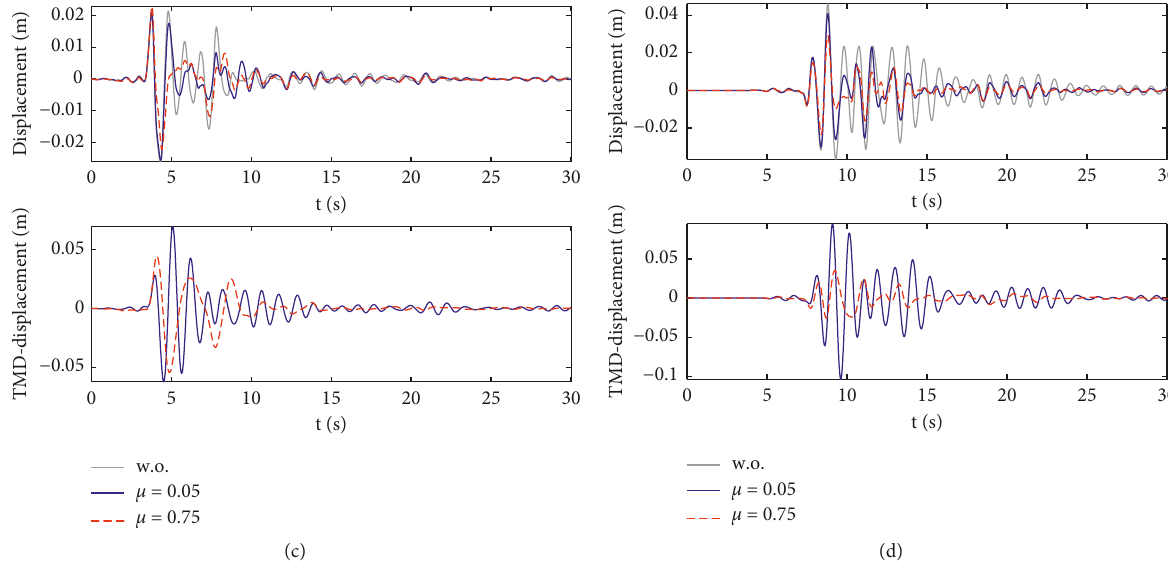
Figure 14: The damping effect of different mass ratio TMDs on the displacement-time history of the main structure ( T relative displacement-time history between the TMD and the structure (w.o. denotes the displacement of a structure without a TMD). (a) El Centro. (b) Hachinohe. (c) Northridge. (d)